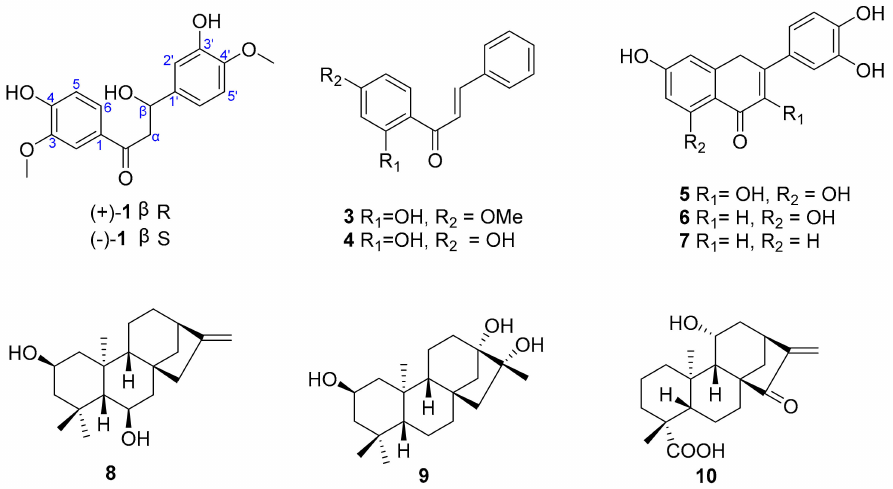
Figure 2. Structures of compounds 1 – 10